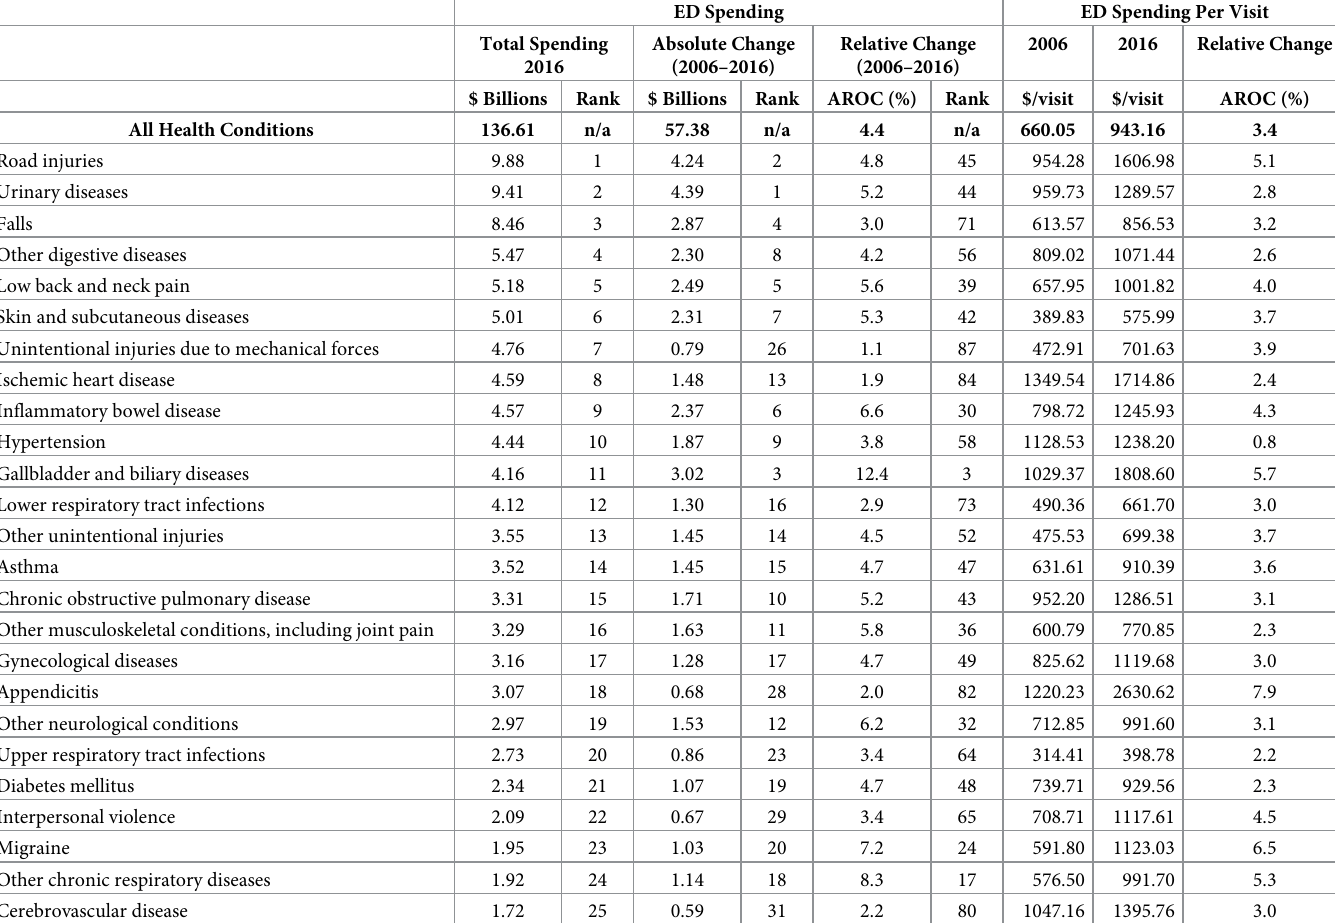
Table 1. Changes in overall Emergency Department (ED) spending and ED spending per visit over time for the 25 health conditions with the most ED spending in